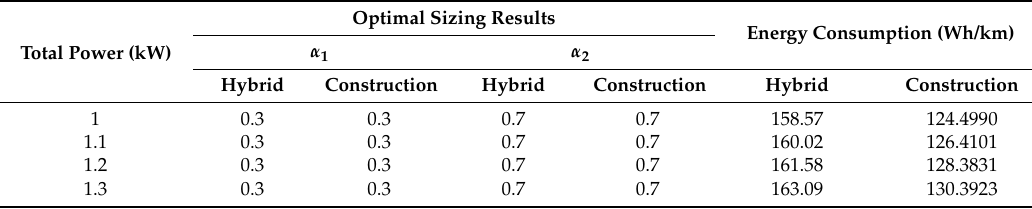
Table 5. Energy consumption in four